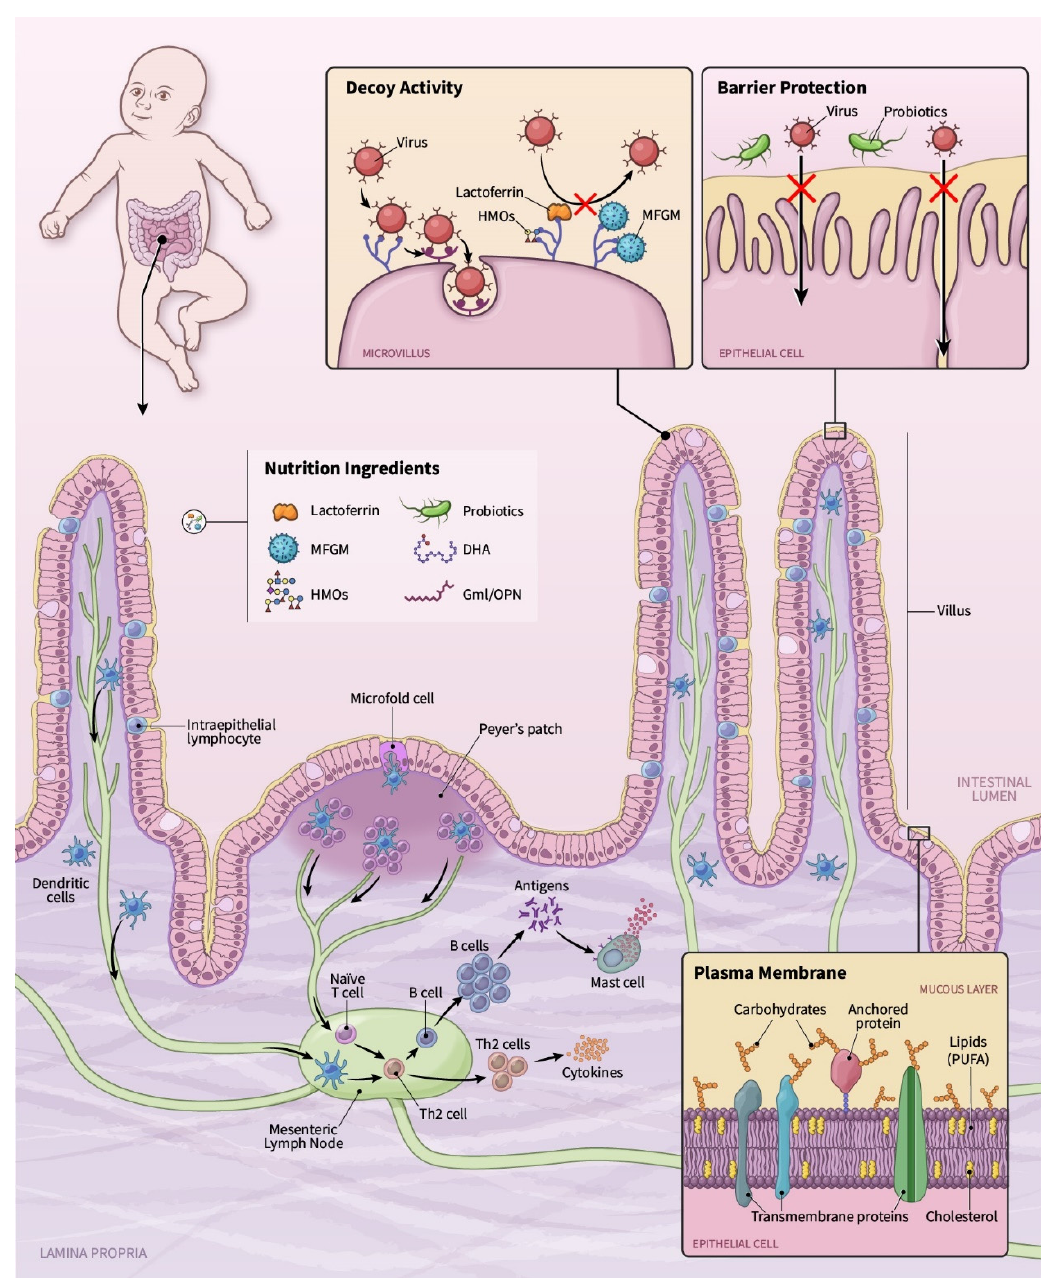
Figure 1. Legend: Functional nutrition ingredients can provide anti-viral activities when consumed and made available within the GI tract. Anti-viral activities can occur through reducing infectivity and binding to the gut epithelial cells. Ingredients can provide decoy activity such that they provide viral receptor binding limiting the ability of virus’ cell adhesion and infection. Ingredients can also support anti-viral infectivity through stimulating the local (and systemic) immune system response. Ingredients interact with intestinal immune cells through dendritic cell or M cell sampling. This sampling goes on to influence T and B cell production within the mesenteric lymph nodes, leading to a modified adaptive immune response, as measured through altered T/B cells, secretory IgA as well as inflammatory cytokines. Ingredients may also stimulate the gap junction protein function leading to decreased translocation of bacterial and viral products. The plasma membrane is the integral interface from which virus’ interact with cells. Modifications to the gut-associated lymphoid tissue inform the broader systemic immune system response. Thus, modulating the immune system through nutrition may be an effective way to provide broad anti-viral